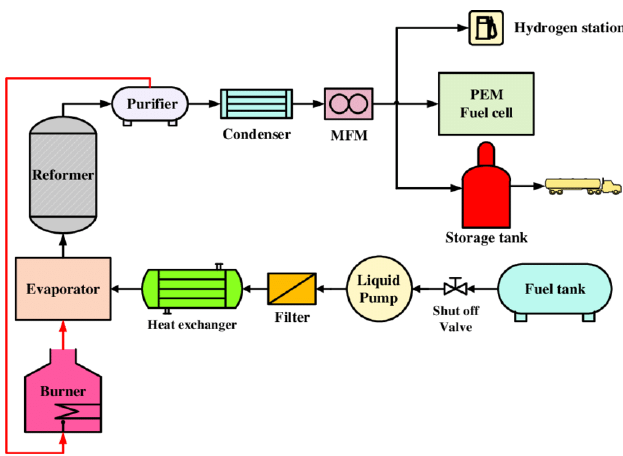
Figure 6. Scheme for a methanol reforming system. Reprinted with permission from [51].